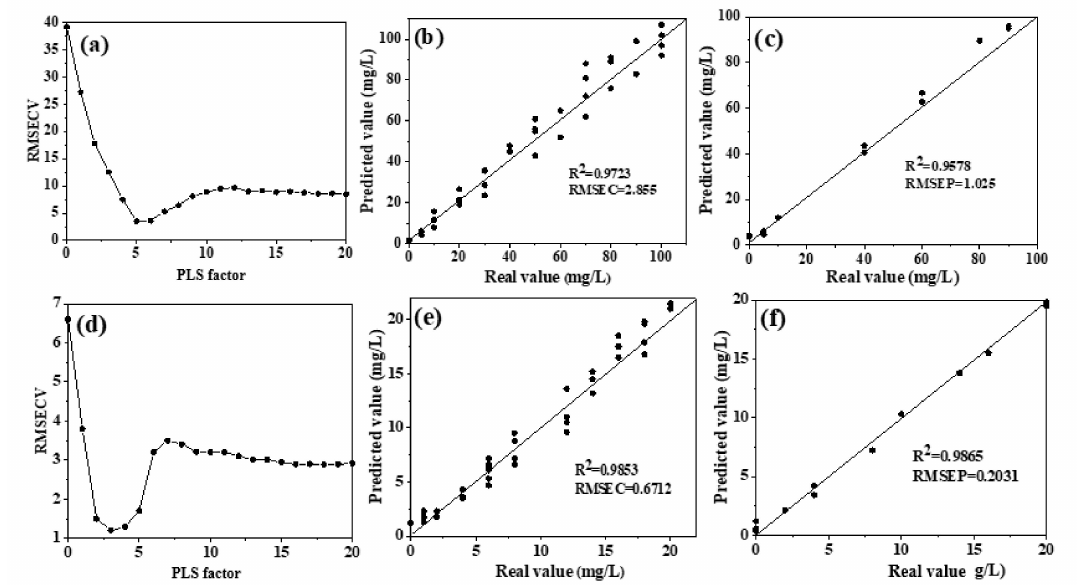
Figure 5. Distribution and model evaluation of the PLS factor ( a , d ), training set (( b , e ); n = 36), and testing set (( c , f ); n = 12) of the PLSR prediction model with deconvolution (without water deduction) for high nitrate solutions ( a – c ) and low nitrate solutions ( d – f ). Note: RMSECV , root mean square error in cross validation; RMSEC , root mean square error of calibration; RMSEP , root mean square error of prediction.